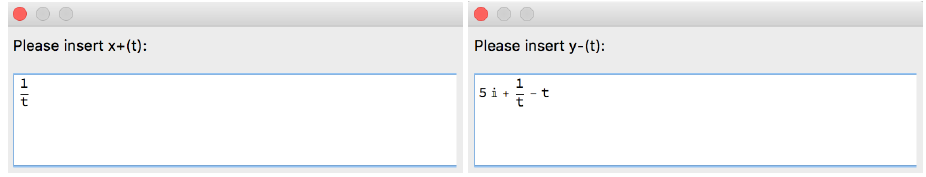
Figure 16. Part of the structure of the [SInt] algorithm corresponding to the Input of x + and y − .